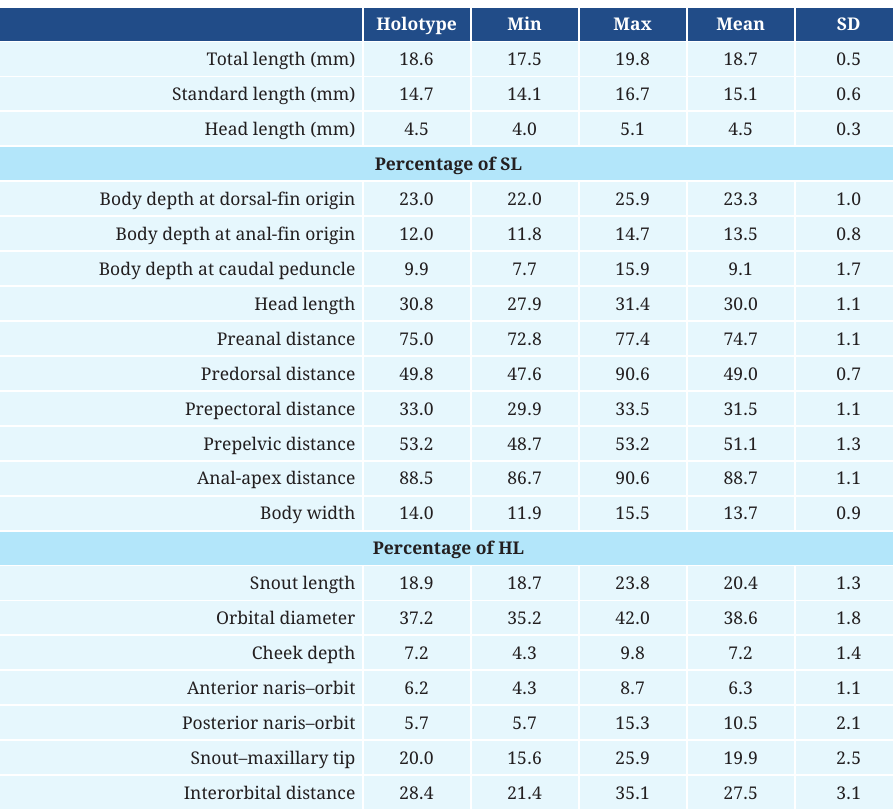
TABLE 1 | Morphometrics of Odontocharacidium varii . Number of individuals (20), mean, minimum (Min), maximum (Max) and standard deviation (SD) include values of the